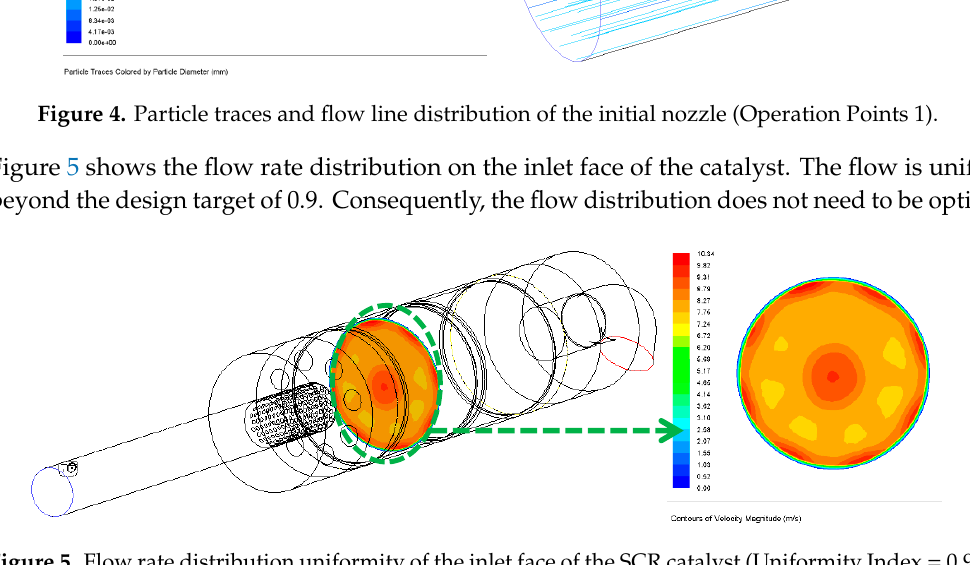
Figure 5. Flow rate distribution uniformity of the inlet face of the SCR catalyst (Uniformity Index = 0.94, Operation Points 1).